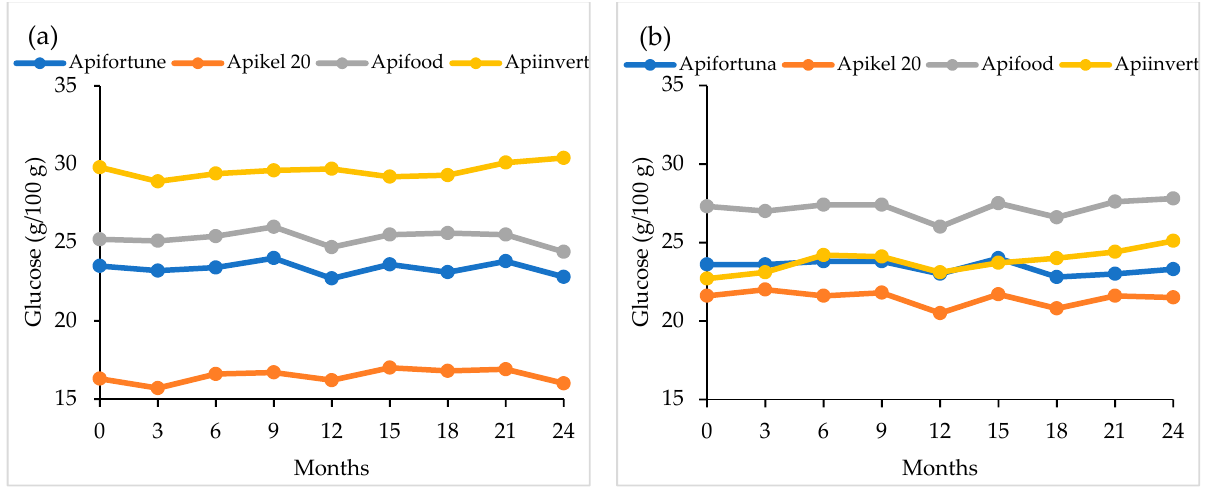
Figure 7. Changes of glucose content in syrups during storage at about 20 °C ( a ) from 2012 and ( b ) from 2013.